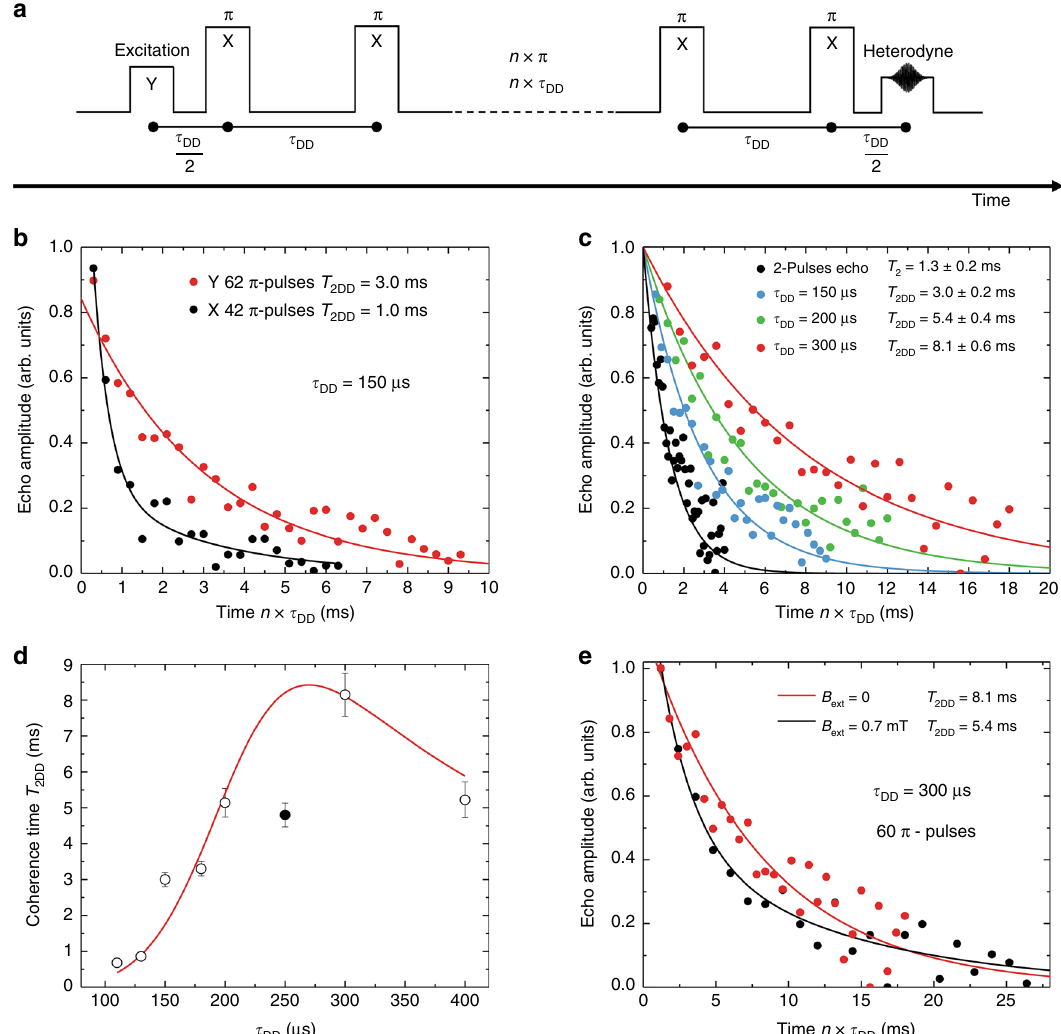
Fig. 3 All-optical dynamical decoupling. a CPMG sequence with optical 2-color excitation and rephasing π pulses. The initial excitation pulse has a Y phase and the π pulses an X phase. This is obtained by varying the relative phase between the two frequency components of the optical pulses. b Echo decays (circles) for different initial phases and exponential fi ts (lines). A much lower T 2DD is observed for an X initial phase (~1.0 ms) than for an Y one (~3.0 ms). This is due to the accumulation of pulse errors and con fi rms that our DD sequence behaves as a CPMG one. c Spin-echo decays (circles) obtained for τ DD = 150, 200 and 300 µ s with n ≤ 60, and exponential fi ts (lines). d Experimental (circles) and modelled (line) T Supplementary Fig. 5). The data point represented by the black circle was discarded for the fi t. e Spin-echo decays (circles) with and without a weak magnetic fi eld. Solid line: exponential fi ts. Error bars and uncertainties correspond to ±1 standard